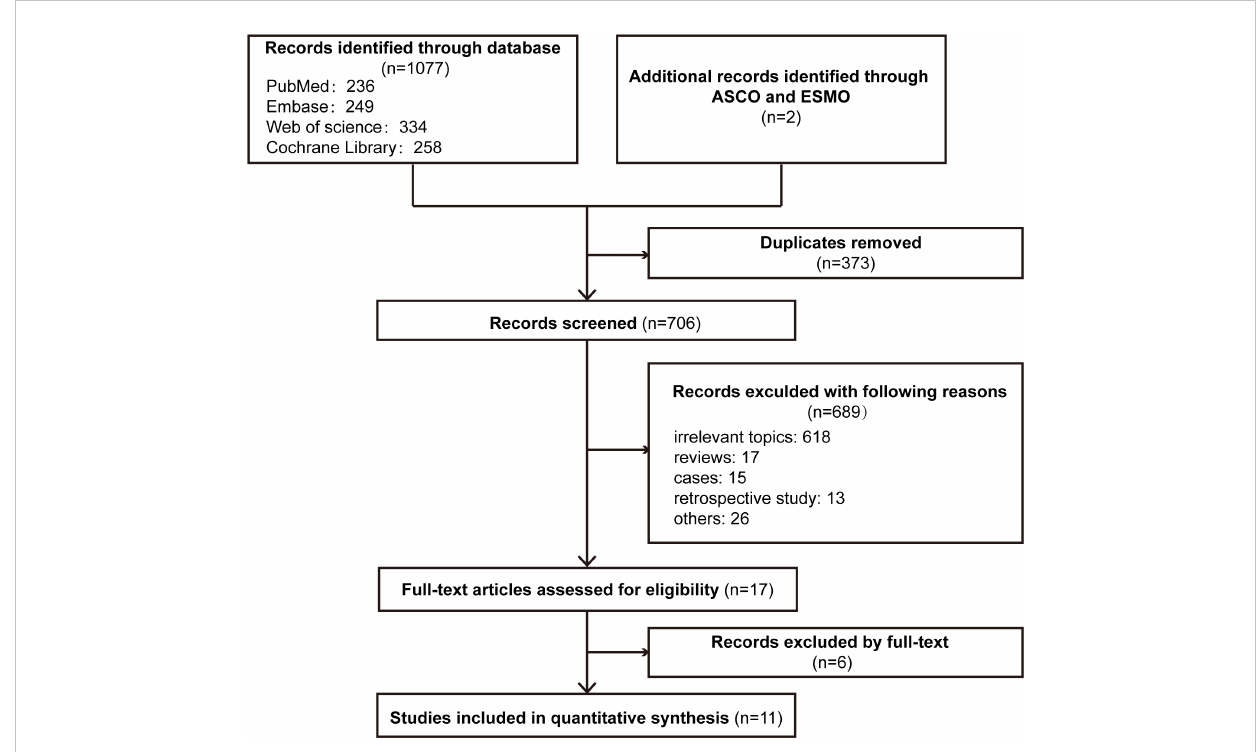
FIGURE 1 Flowchart of the study selection process for the meta-analysis.